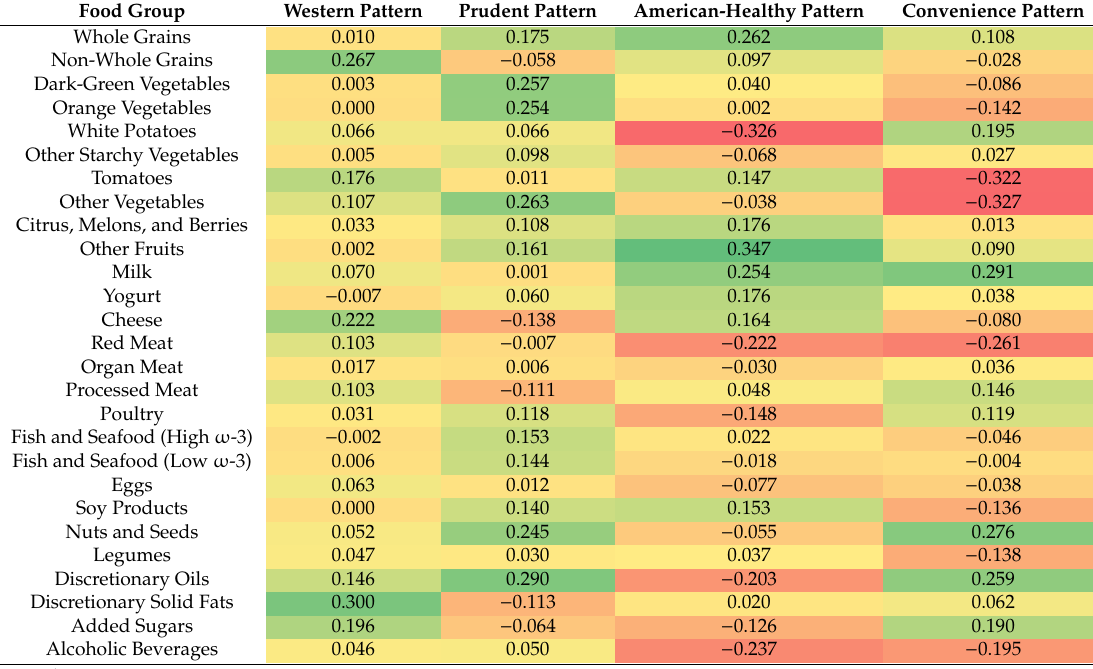
1 Factor loadings represent the magnitudes and directions of associations with factors (dietary patterns) and can range from − 1.0 to 1.0. Stronger negative factors are shaded in red, stronger positive factors are shaded in green, and yellow and lighter shades are intermediate.